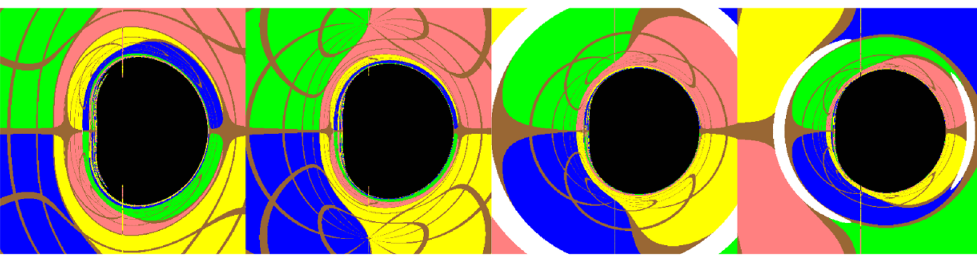
Figure 4 . The change of black hole shadow with the coupling constant α for the metric (2.21). Here we set the black hole M = 1 and rotation parameter a = 0 . 998, and the observer locates in the position with r obs = 50 M and θ obs = π/ 2. The figures from left to right correspond to α = 0 . 2, 0, and 0 . 2, respectively. −